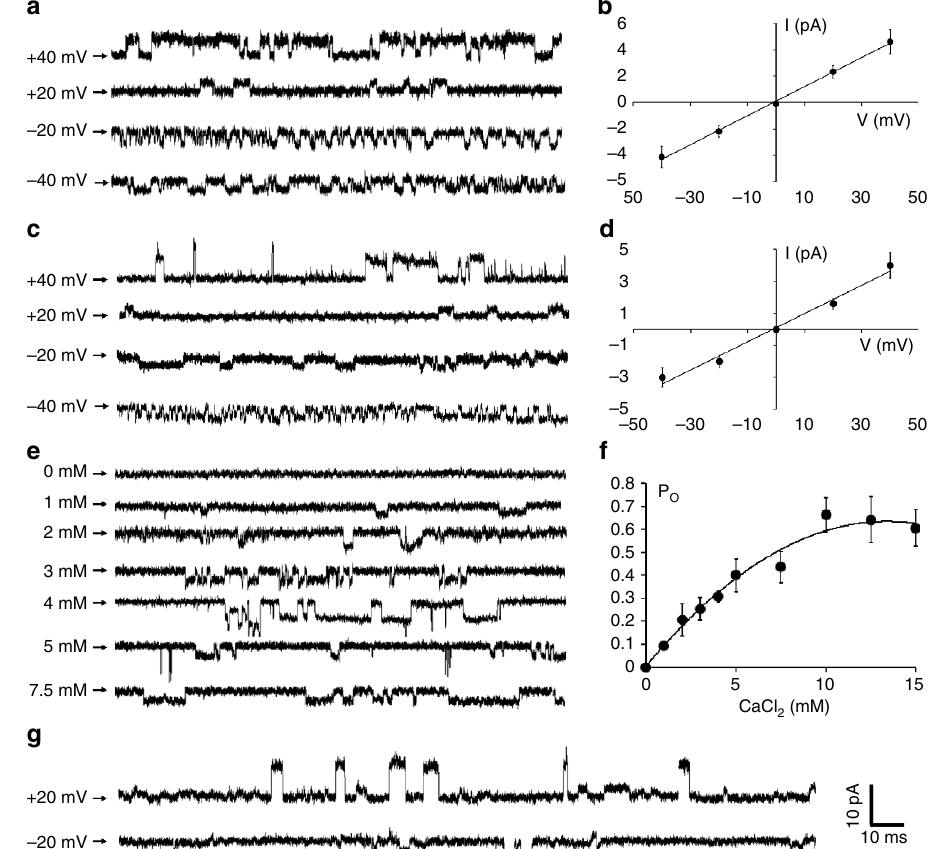
Figure 3 | Results from single-channel recordings. ( a ) Representative current traces of NaKTs ion channel Na þ conductance at different TM potentials (internal solution: 20mM HEPES, pH 7.5; 0.2M NaCl and external solution: 20mM MOPS, pH 4; 0.2M NaCl; 5mM CaCl 2 ). ( b ) I / V relationship of NaKTs ion channel in the presence of NaCl. The NaKTs ion channel Na þ conductance is 110pS. ( c ) Representative current traces of NaKTs ion channel K